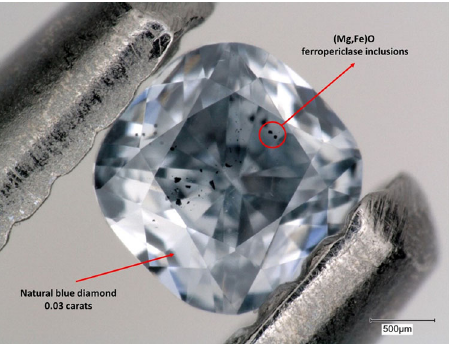
Fig. 2 Natural blue diamond. Natural blue diamond containing black inclusions of ferropericlase (Mg,Fe)O indicating a minimum depth of formation not less than 15 – 16 GPa (about 450 – 480 km depth). The blue colour, as in the Hope diamond from the Smithsonian Institution, is due to the presence of very small amount of boron, B, which substitutes for carbon within the diamond structure. The presence of boron within a super-deep diamond demonstrates how our planet is ef fi cient at recycling light elements crucial for life from the surface to the deepest regions of the Earth (Photo by Evan M.